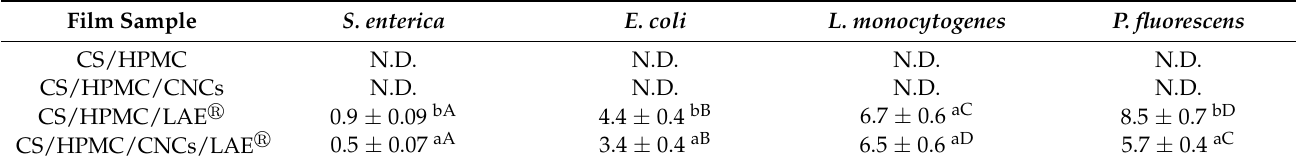
Table 6. Inhibition zone diameters (expressed in mm) of the film disks (18 mm diameter) based on chitosan-hydroxypropyl methylcellulose blend (CS/HPMC) as the control and those reinforced with cellulose nanocrystals (CNCs 10% w / w of biopolymer), and/or enriched with lauroyl arginate ethyl (cid:114) (LAE 5% w / w of